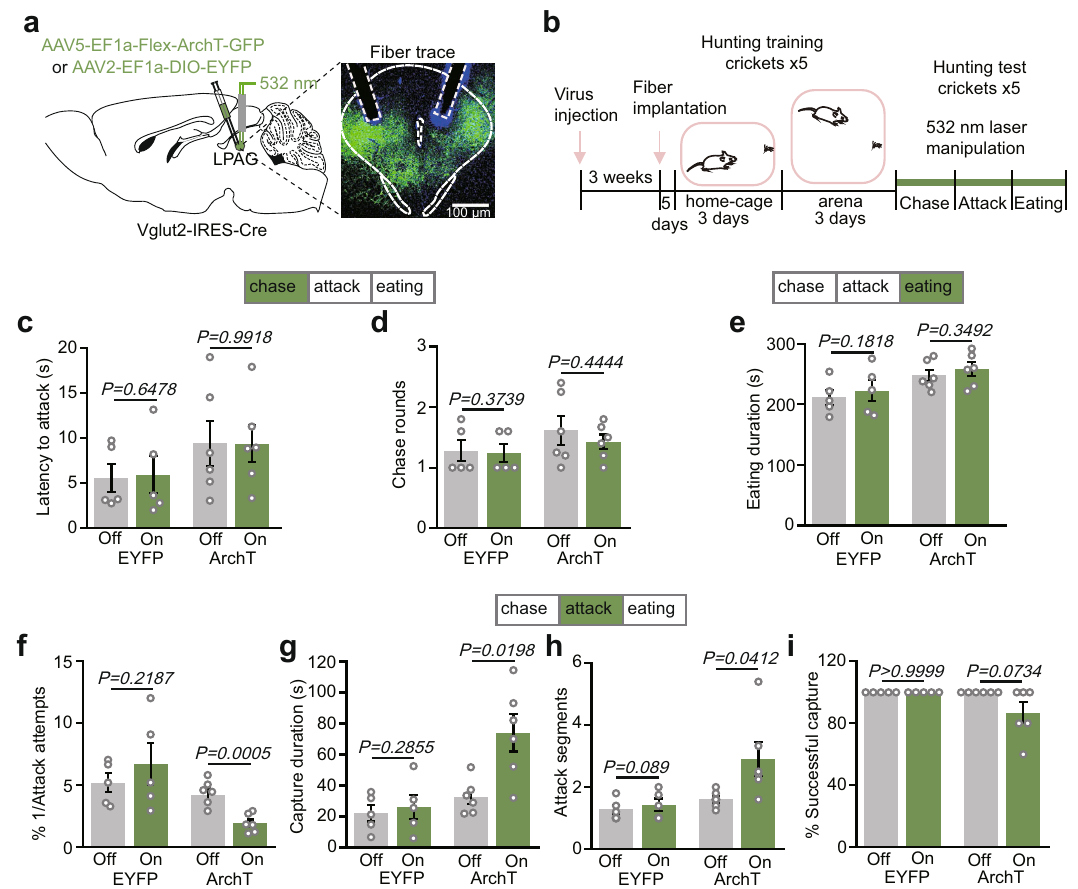
Fig. 4 Phase-speci fi c inhibition of LPAG Vglut2 neurons suppresses predatory attack. a Left, scheme for photoinhibition of LPAG Vglut2 neurons.